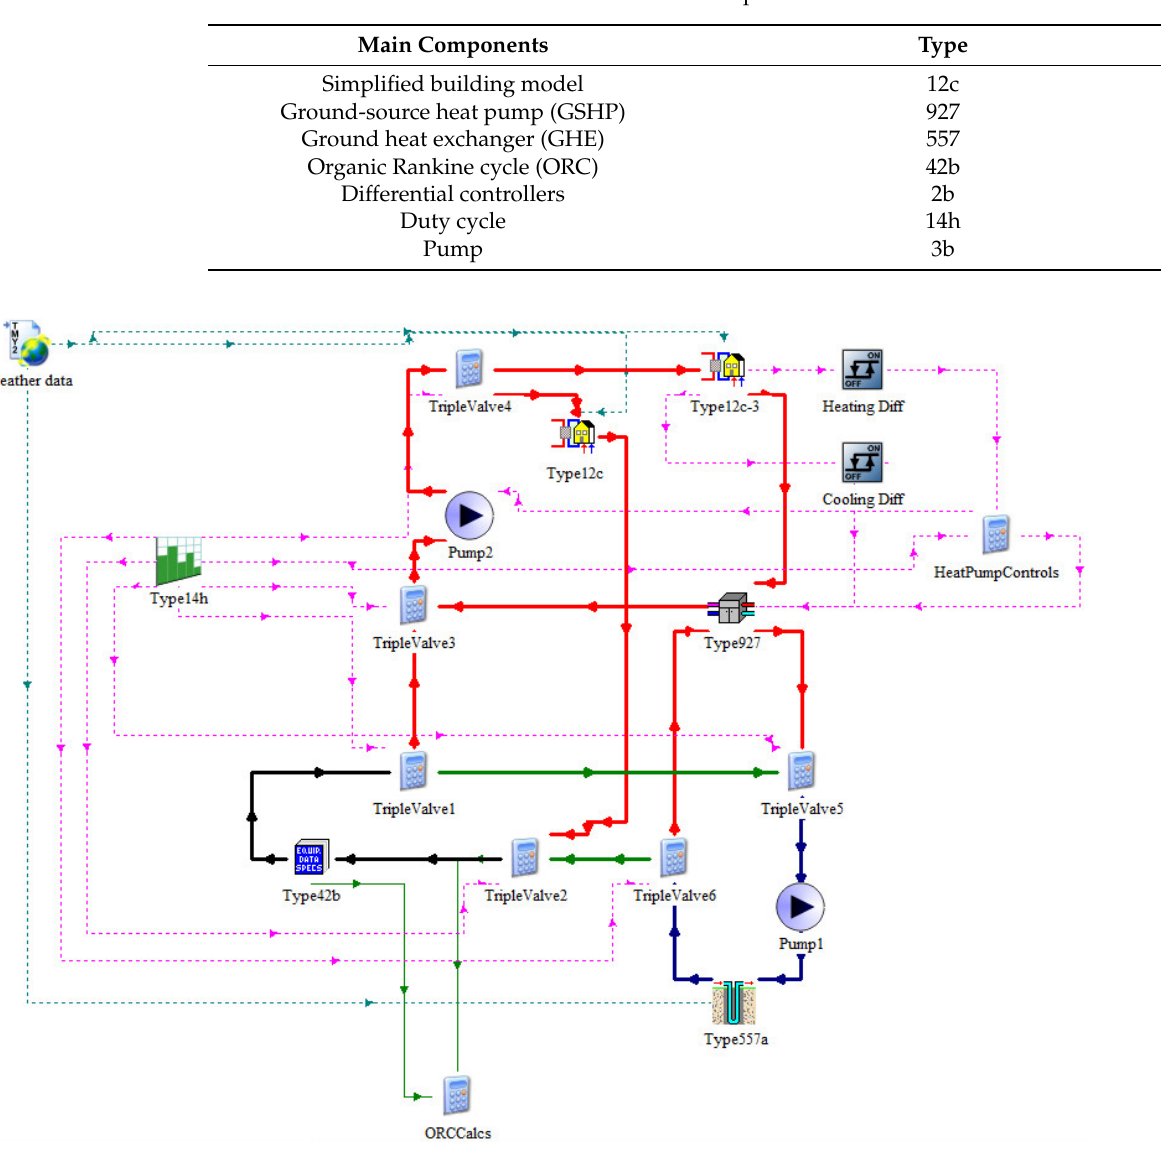
Table 1. TRNSYS simulation models for the main components.